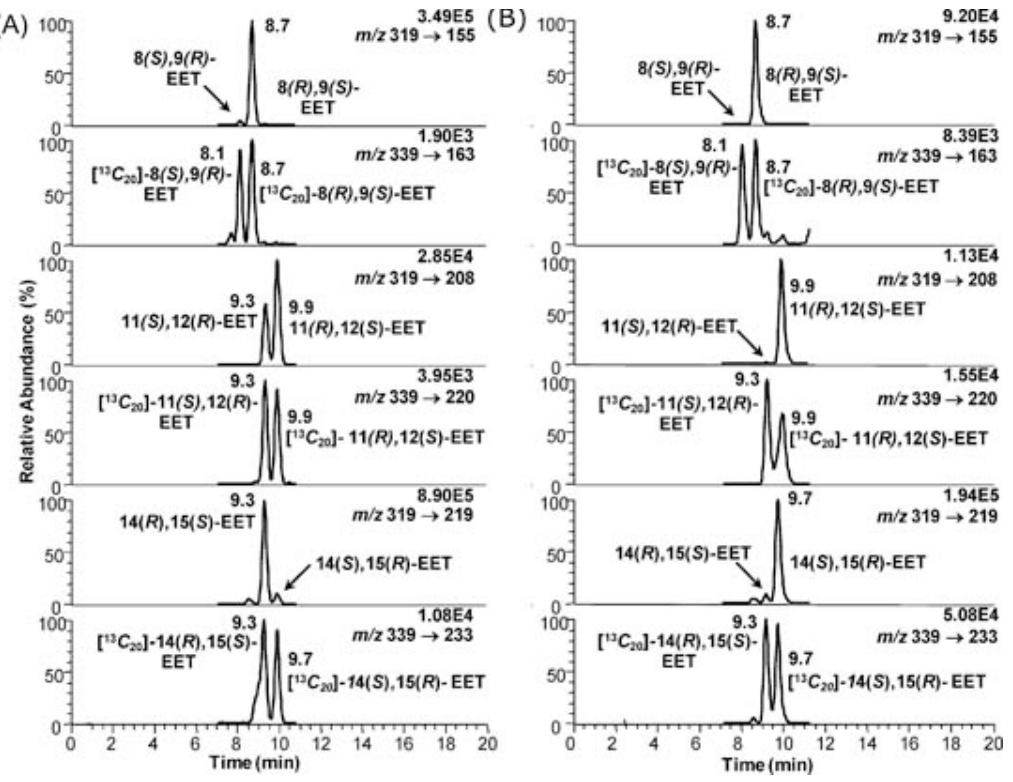
Figure 9. Enantioselective biosynthesis of EETs by CYP family 2